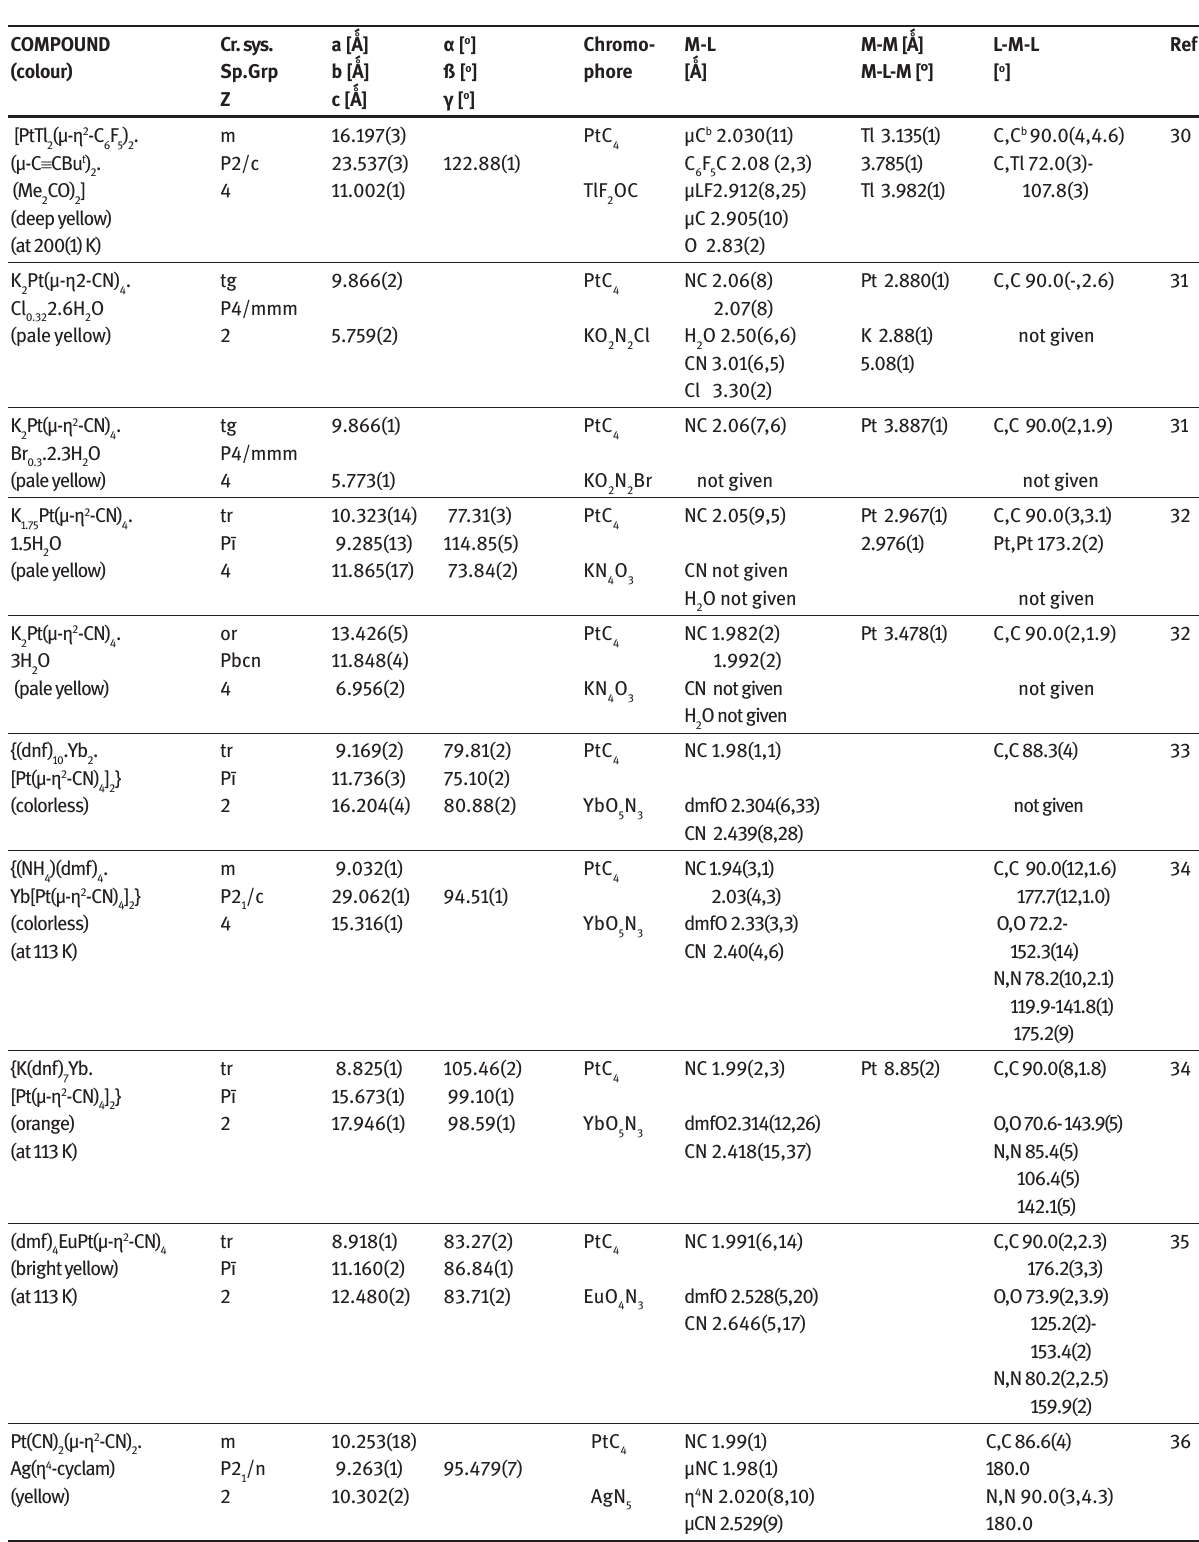
and PtS chromophores a . 4 4